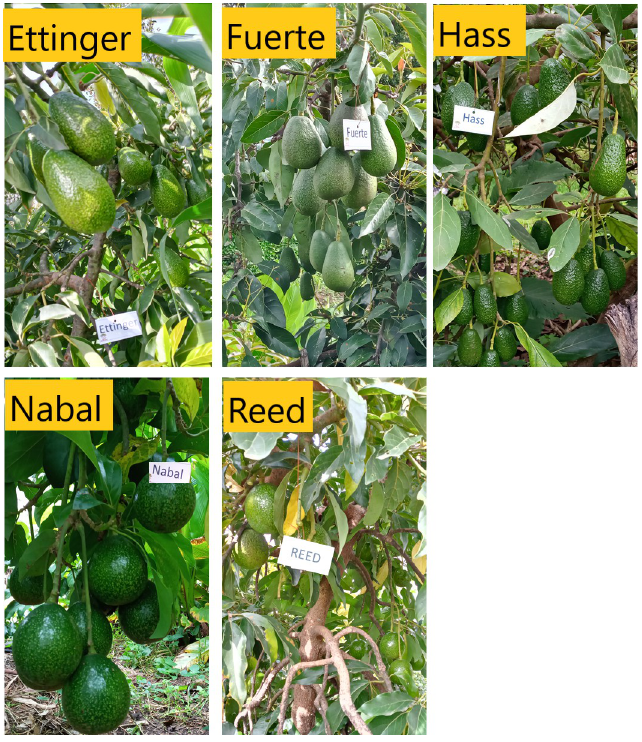
Fig 2. Photographic documentation of the studied avocado cultivars during fruit sample